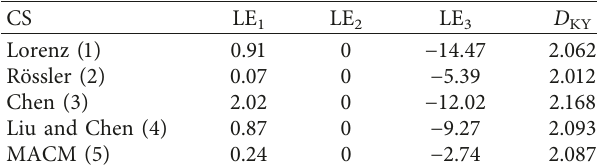
Table 2: LEs of the CSs (1)–(5) in their